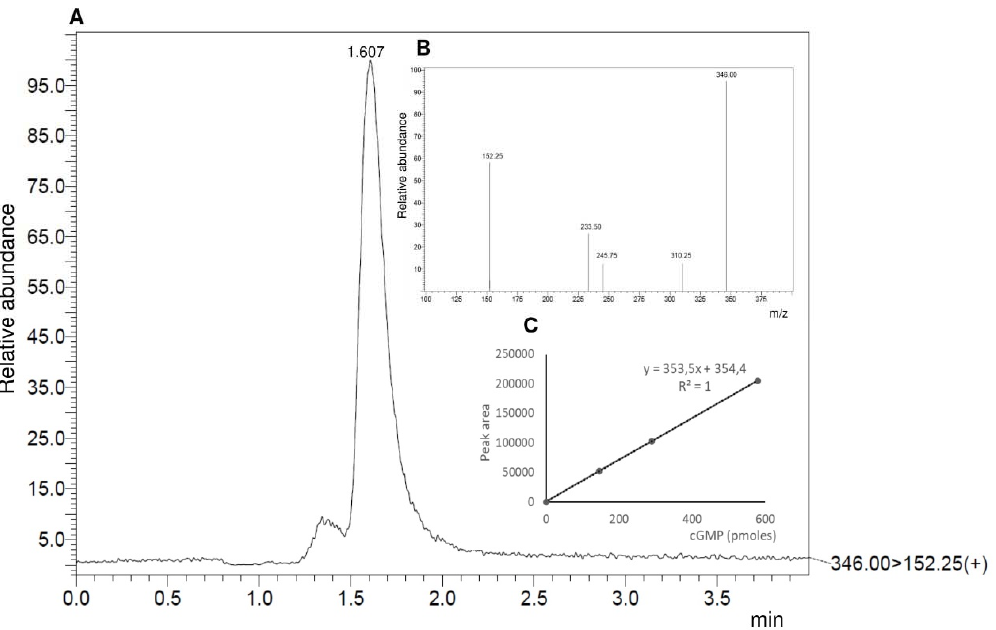
Figure 2. Enzymatic activity of recombinant BdPepR2. ( A ) Recombinant BdPepR2 activity in response to various concentrations of GTP. Reaction mixture contained 50 mM Tris/HCl buffer (pH 7.5), 5 mM MnCl 2 , GTP (0.5–2 mM), and 5 μ g of purified protein (without GST-tag) in a final volume of 100 μ L. ( B ) Determination of BdPepR2 cofactor specificity. Reaction mixture contained 50 mM Tris/HCl buffer (pH 7.5), 5 mM MnCl 2 and/or 5 mM MgCl 2 , 1.5 mM GTP and 5 μ g of purified protein (without GST-tag) in a final volume of 100 μ L. ( C ) Determination of BdPepR2 substrate specificity. Reaction mixture contained 50 mM Tris/HCl buffer (pH 7.5), 5 mM MnCl 2 , 1.5 mM GTP or 1.5 mM ATP, and 5 μ g of the purified protein (without GST-tag) in a final volume of 100 μ L. Data are mean values (n = 3), and error bars show standard error of mean. Statistical analysis was performed by one-way ANOVA followed by a Tukey–Kramer multiple comparison test. Different letters indicate significantly different data.